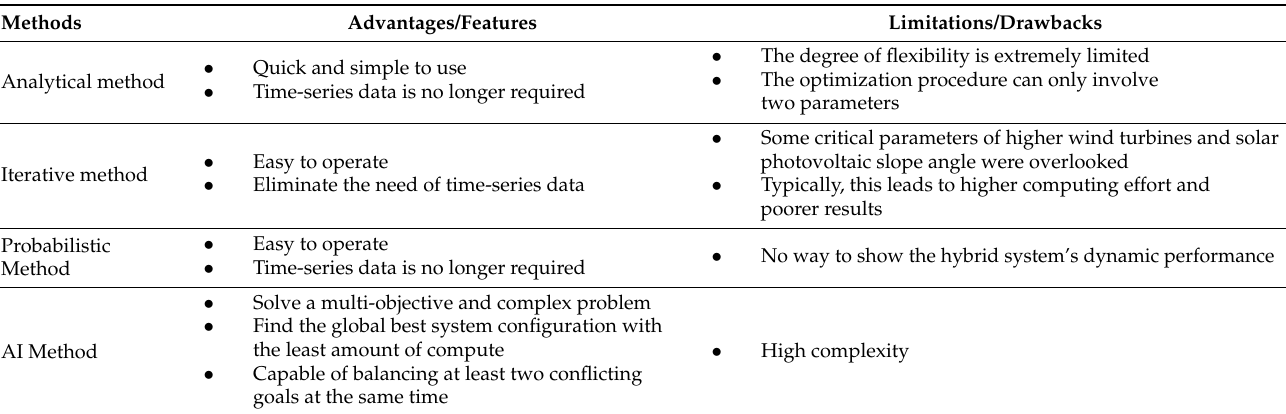
Table 9. Comparison of various scaling approaches (conventional approach) employed in hybrid systems